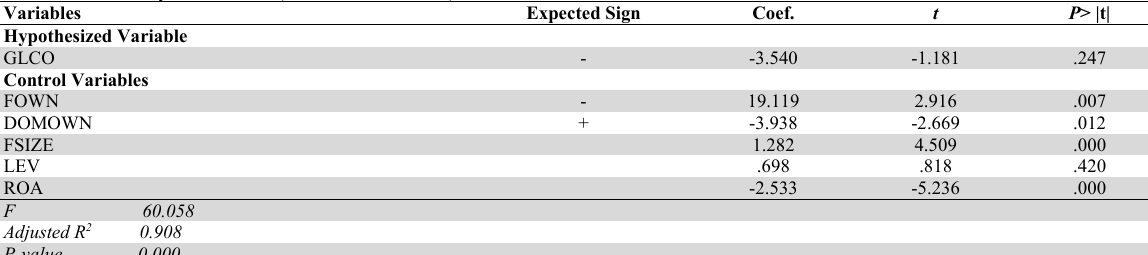
Pooled OLS Analysis Results (Board size